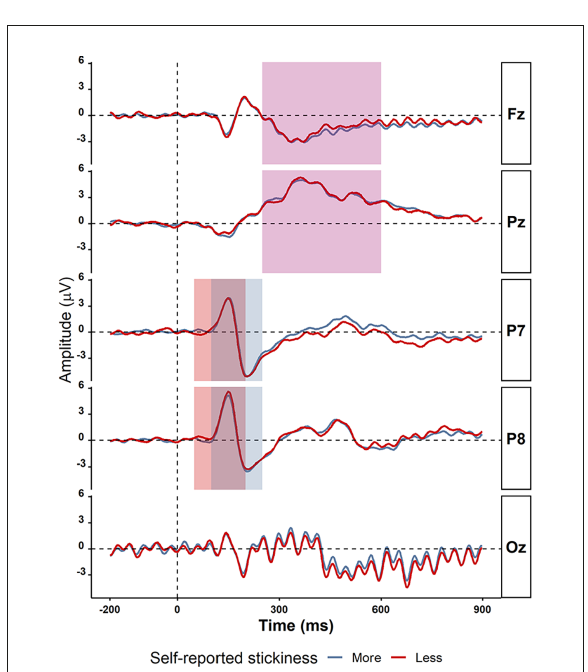
FIGURE4 Grand average ERPs in electrodes P7, P8, Fz, Pz, and Oz comparing more sticky trials (red) and less sticky trials (blue). The time windows for detecting peaks of ERPs components are shown in the rectangles: P1 (50–200 ms in light green), N1 (100–250 ms in light purple), and P3 (250 − 600 ms in light yellow). There were no significant differences between more and less sticky